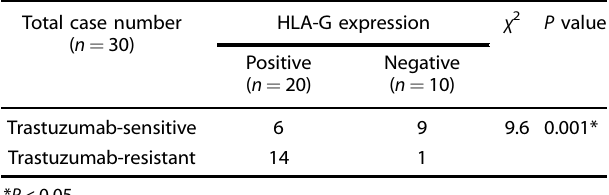
Table 1. The association of HLA-G expression with trastuzumab response in patients with HER2-positive breast cancer ( n = 30)